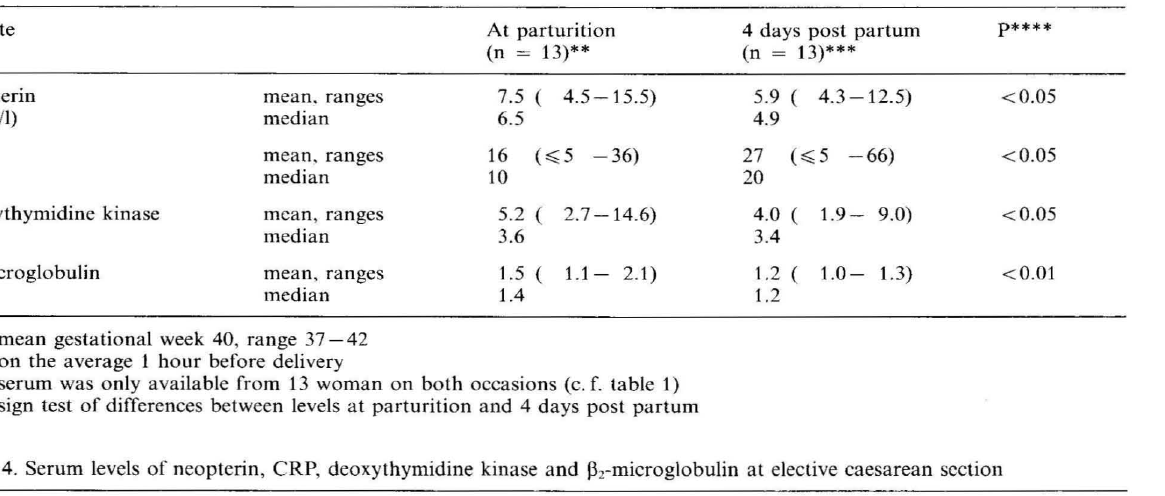
Table 3. Maternal serum levels of neopterin, CRP, deoxythymidine kinase an ~Tmicroglobulin at vaginal delivery and 4 days post partum* Analyte